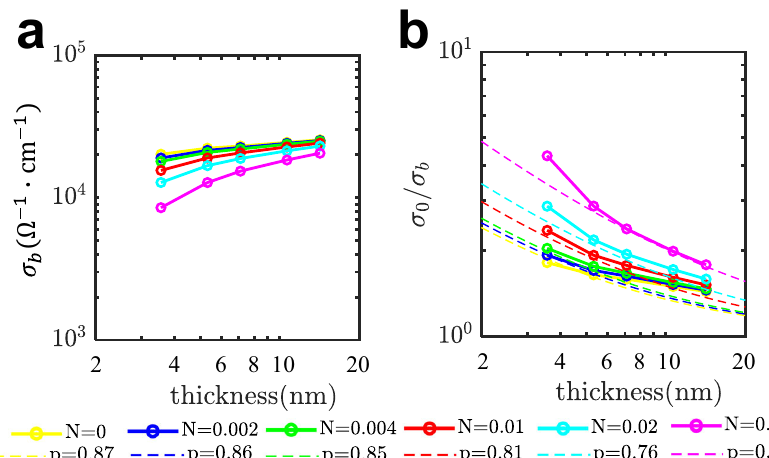
Fig. 4 Scaling of bulk-state conductivity in CoSi slabs. a Pure bulk conductivity σ b (not including the surface state contribution) as a function of slab thickness, for different surface defect density N N ¼ 0 : 01isequivalenttoarealdensity (cid:2) 5 ´ 10 12 cm (cid:5) 2 ð Þ . The range of thickness considered corresponds to region I of Fig. 3. b Inverse ratio of the bulk conductivity σ b to the in fi nite thickness conductivity σ 0 . The numerical data are fi t to the Fuchs – Sondheimer model. The probability of specular surface scattering, p , decreases as N